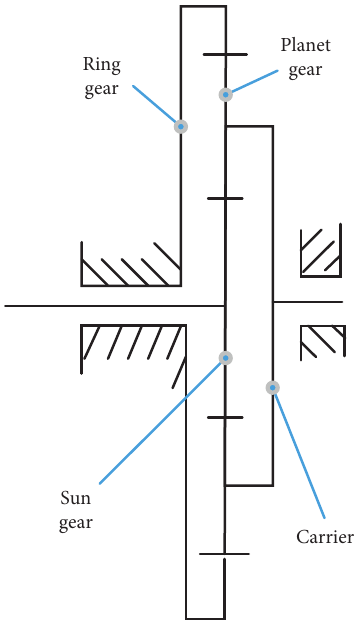
Figure 1: The structure diagram of a 2K-H planetary gear model.